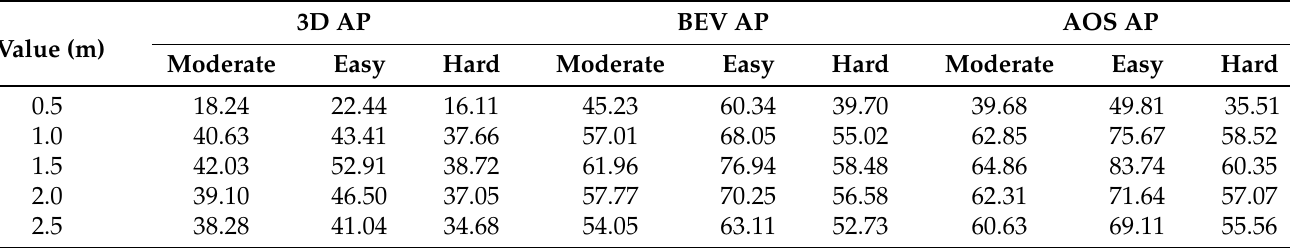
Table 5. Comparison of different receptive fields in the proposed virtual